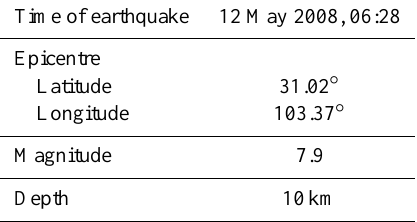
Table 1. Details of the Sichuan